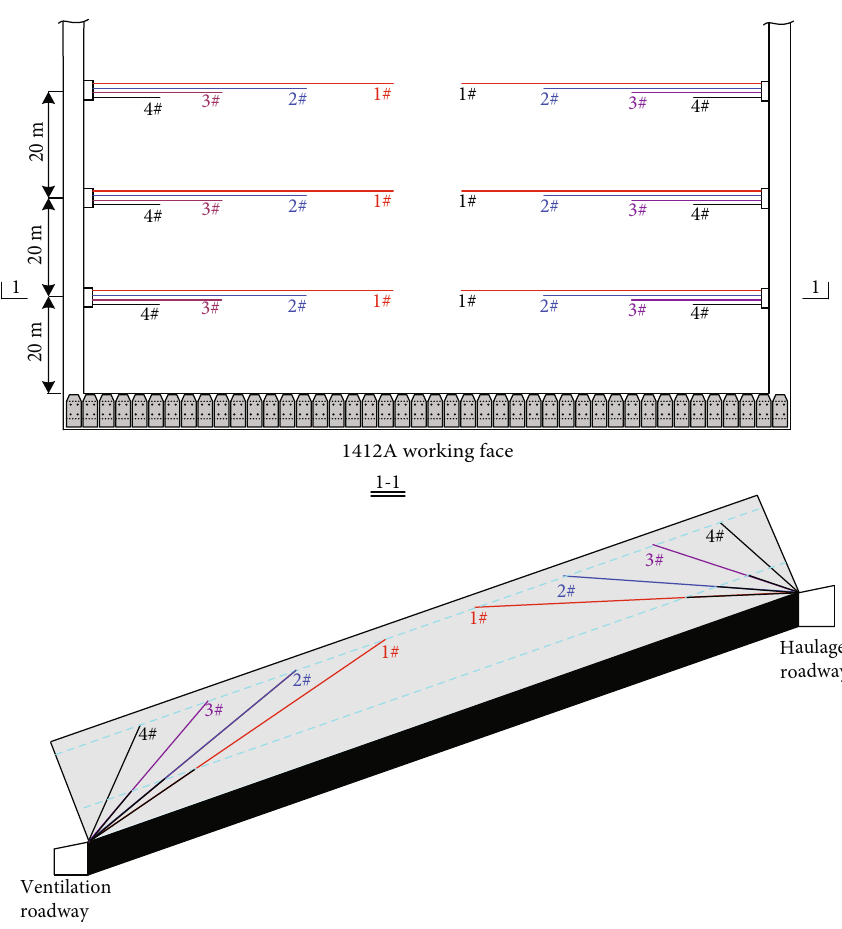
Figure 11: Layout of blasting hole cutting